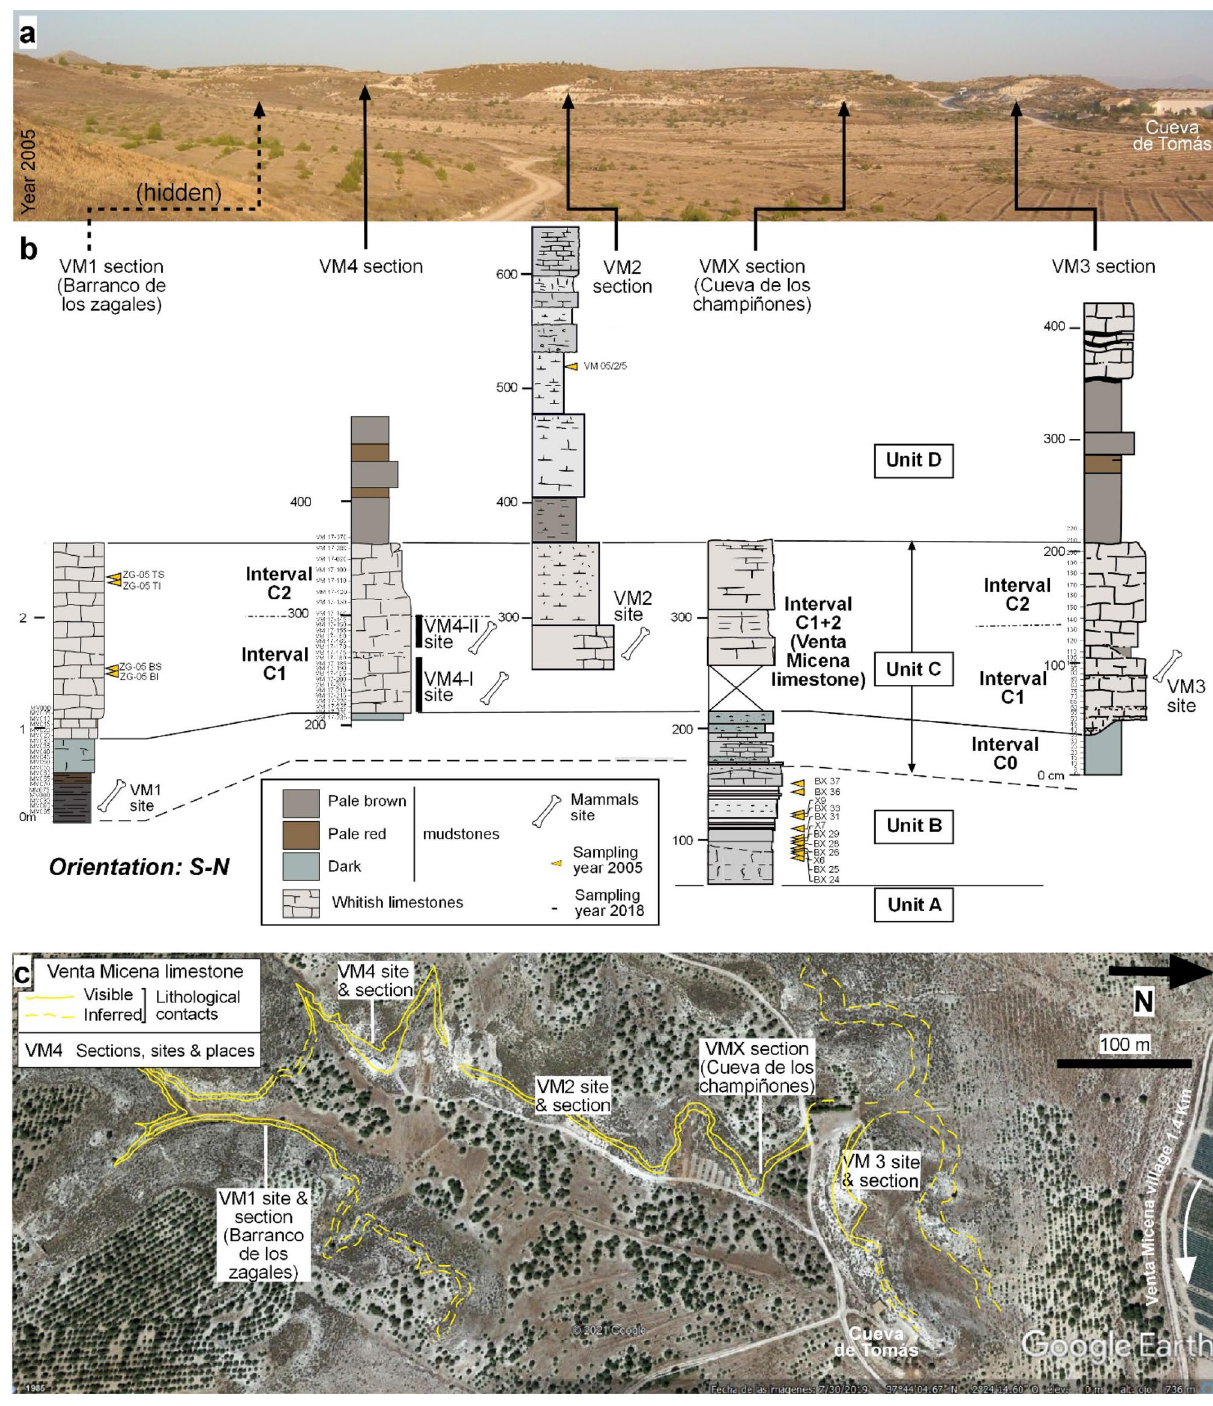
Figure 2. The Venta Micena (VM) limestone sections 15 investigated in this study: ( a ) Location in a landscape ground view (own picture). ( b ) Lithology and indication of the sampling levels (see results in further figures and Supplementary Notes S1). Carbonate rocks have been differentiated on the basis of the carbonate content (figure created with Inkscape 1.0.1 software, https:// inksc ape. org/ es/). ( c ) Satellite image (Google EARTH and Instituto Geográfico Nacional, Spain) with a rough indication of the limestone distribution. ‘Cueva de Tomás’ is the cave house that was the reference section including VM3 15 . Additional stratigraphic data and results are presented in Supplementary Notes